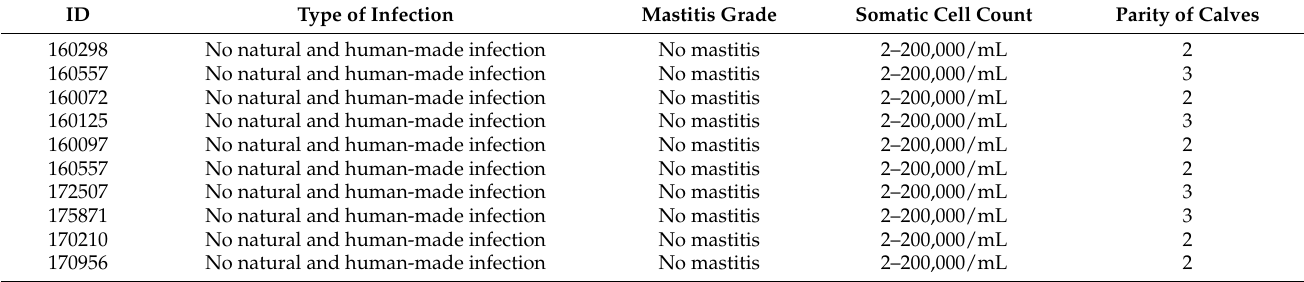
Table 3. Healthy cows.